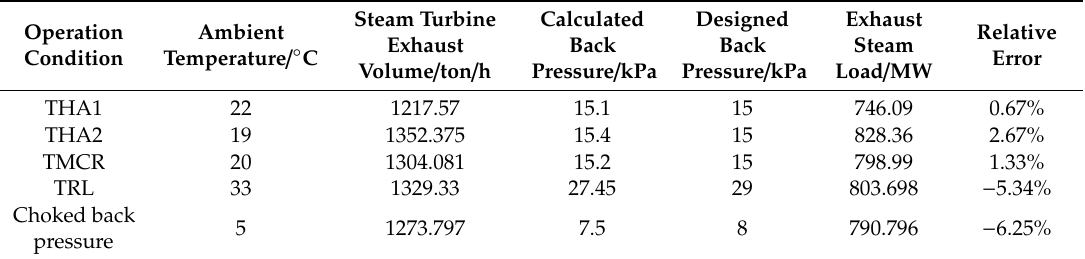
Table 2. Comparison between the model results and the design back